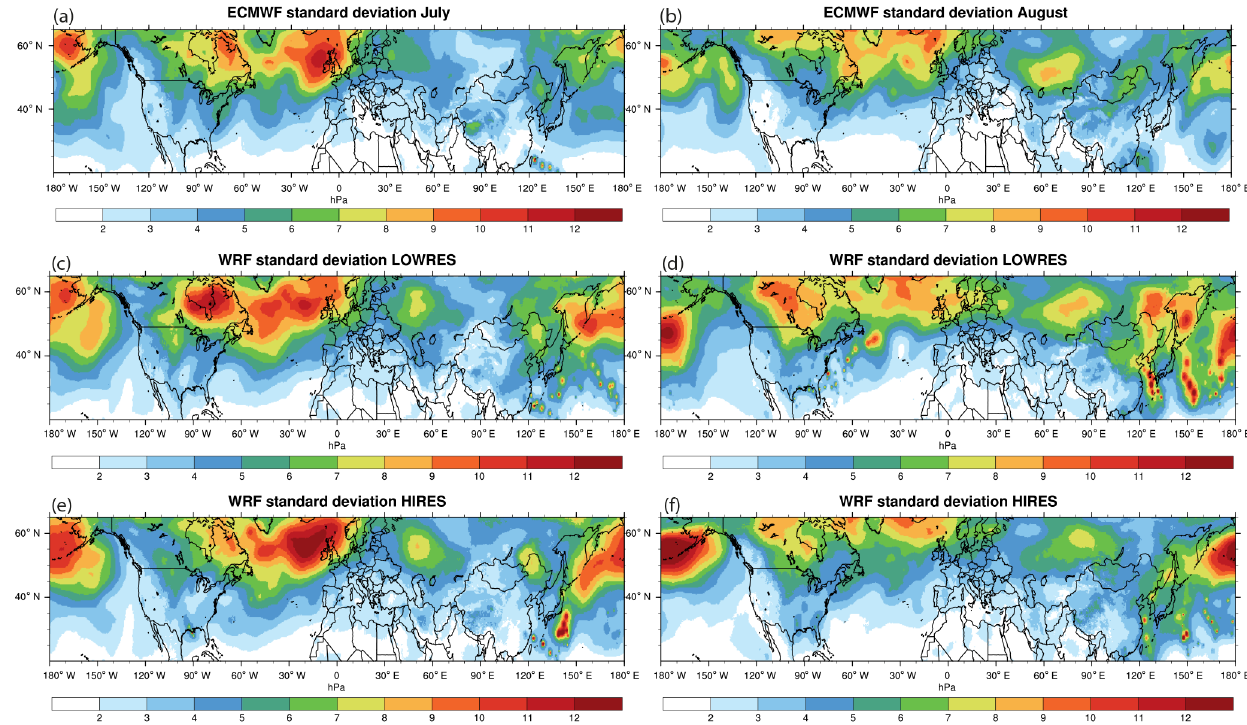
Figure 7. Mean sea level pressure standard deviation at 12:00UTC for July 2013 (a, c, e) and August 2013 (b, d, f) . The top row shows the ECMWF analysis, the middle row shows the LOWRES simulation, and the bottom row displays the HIRES